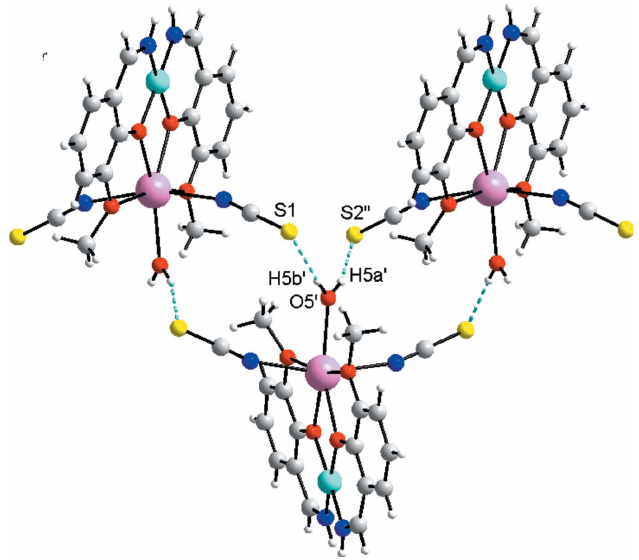
Figure 3 Packing diagram of the title compound, showing intermolecular O— H (cid:2)(cid:2)(cid:2) S hydrogen bonds forming a chain structure. [Symmetry codes: (i) x (cid:3) 1 , (cid:3) y + 1 , z + 1 ; (ii) (cid:3) x , 1 (cid:3) y , (cid:3) z .] 2 2 2